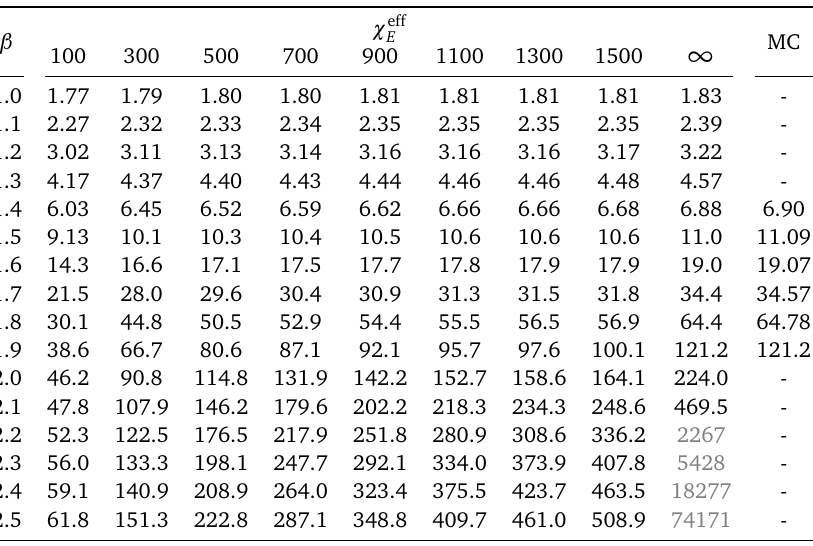
, E = 6. The values at finite χ eff are computed B E